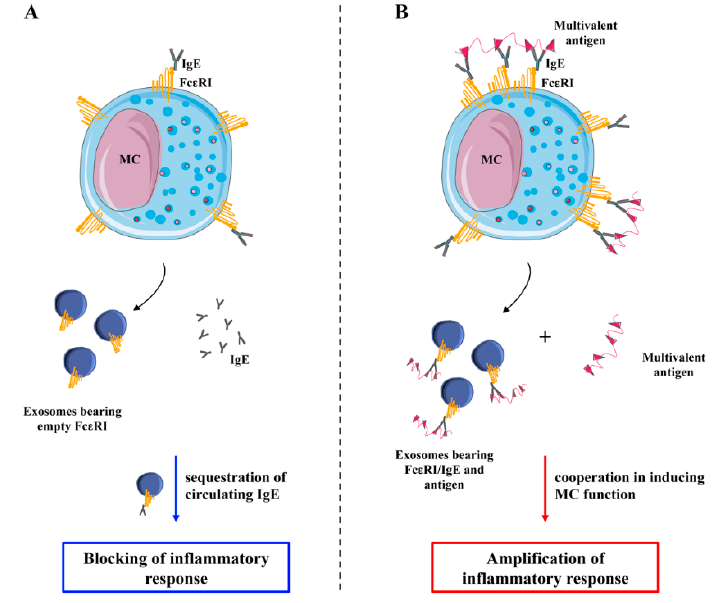
Figure 3. Modulation of IgE dependent inflammatory response by MC-derived exosomes. ( A ) MCs release exosomes bearing empty receptors either constitutively or upon antigen-independent stimuli that can bind free IgE inhibiting the inflammatory response. ( B ) Upon Fc ε RI engagement by means of IgE loading followed by antigen stimulation, MCs release exosomes bearing receptors, IgE, and antigens that can cooperate with soluble multivalent antigens to amplify the inflammatory response.